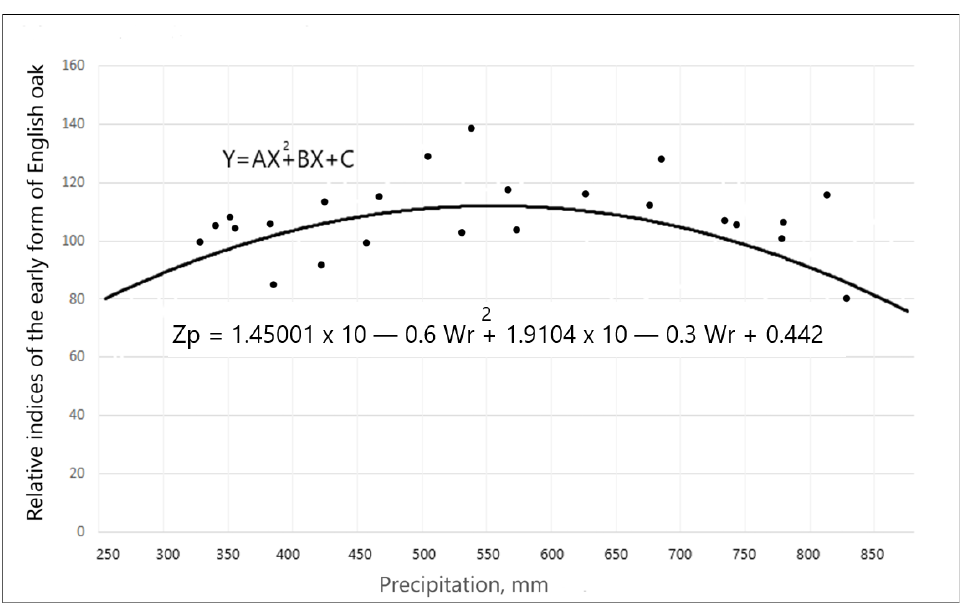
Figure 4. Relationship between relative indices of ARW and annual precipitation in the late form of English oak in the wet goutweed oak stand of Shipov Forest.